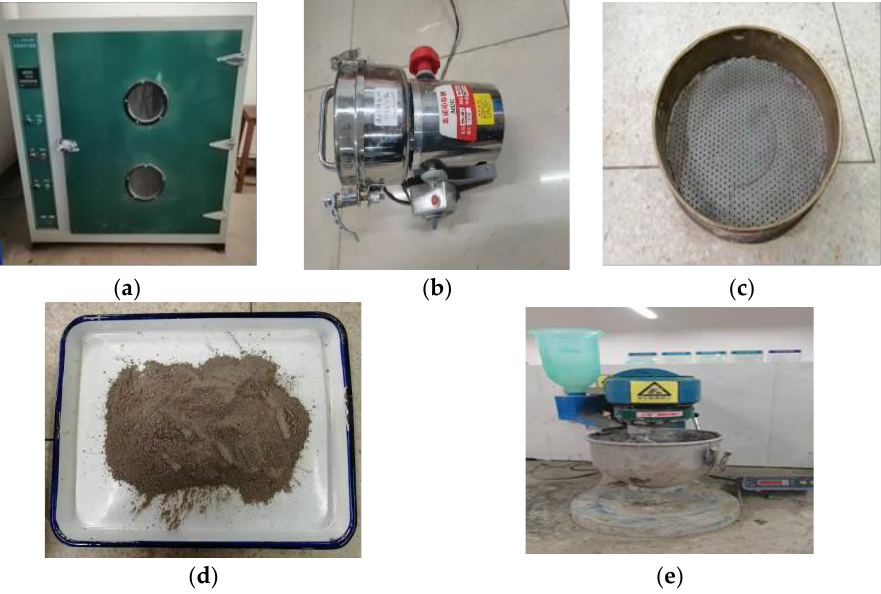
Figure 5. Remolded soil preparation instruments of ( a ) oven, ( b ) grinder, ( c ) sieve, ( d ) crushed dry soil, and ( e ) cement mortar